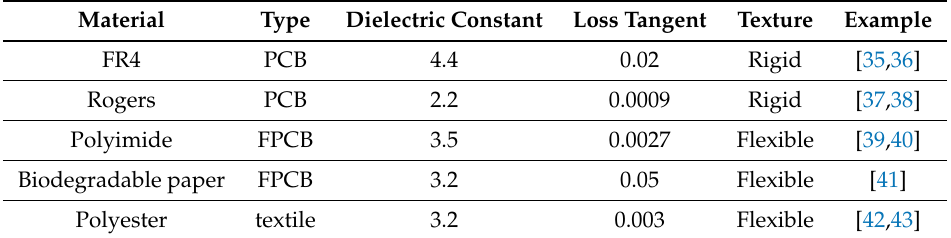
Table 2. Materials of substrates.